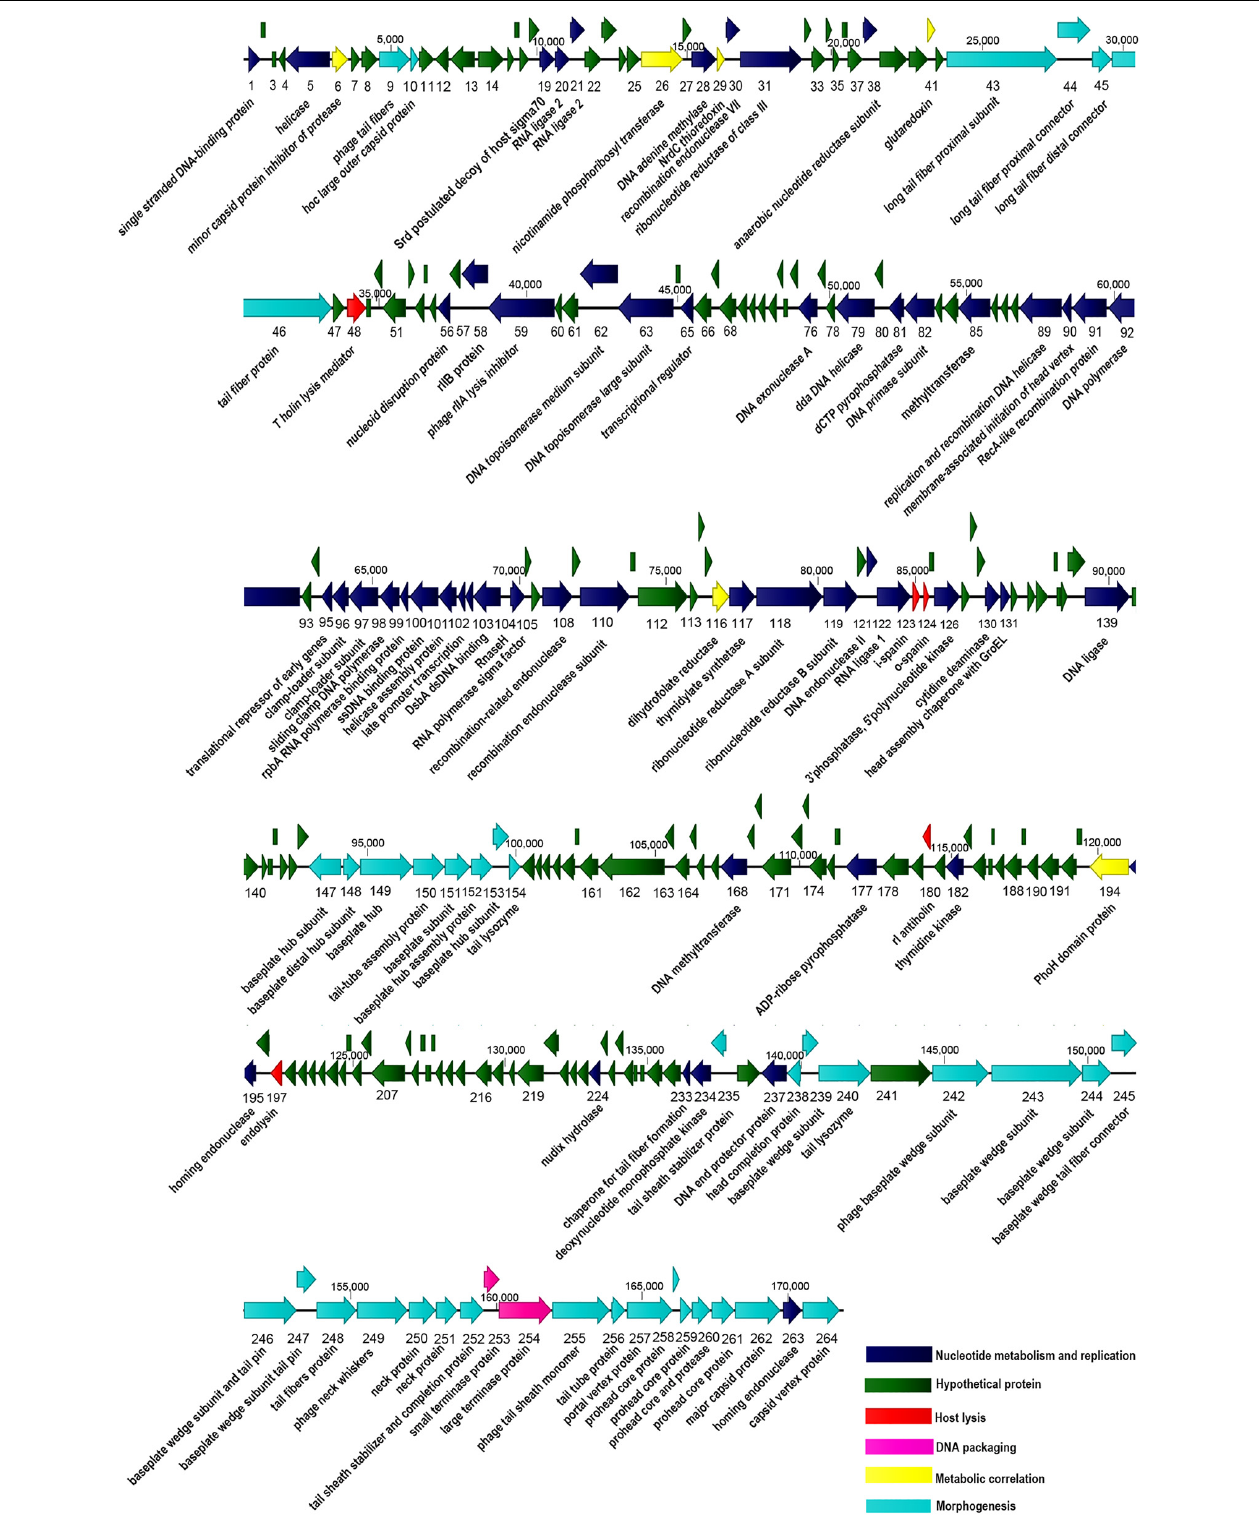
FIGURE 5 | Graphical representation of the phage P-KP2 genome. 264 ORFs and the direction of transcription are presented as arrows. Proposed modules are based on hypothetical functions predicted through bioinformatic analysis. The genome map was generated using CLC Main Workbench (version 8.0.1).